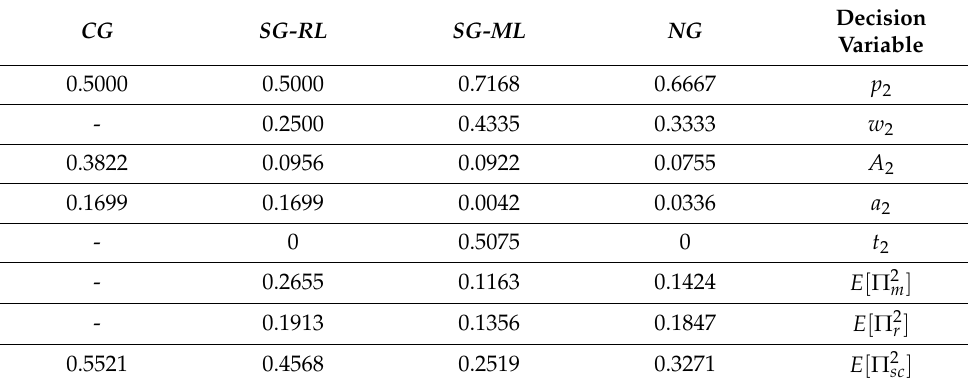
Table 4. The results for the numerical example 1 in the second